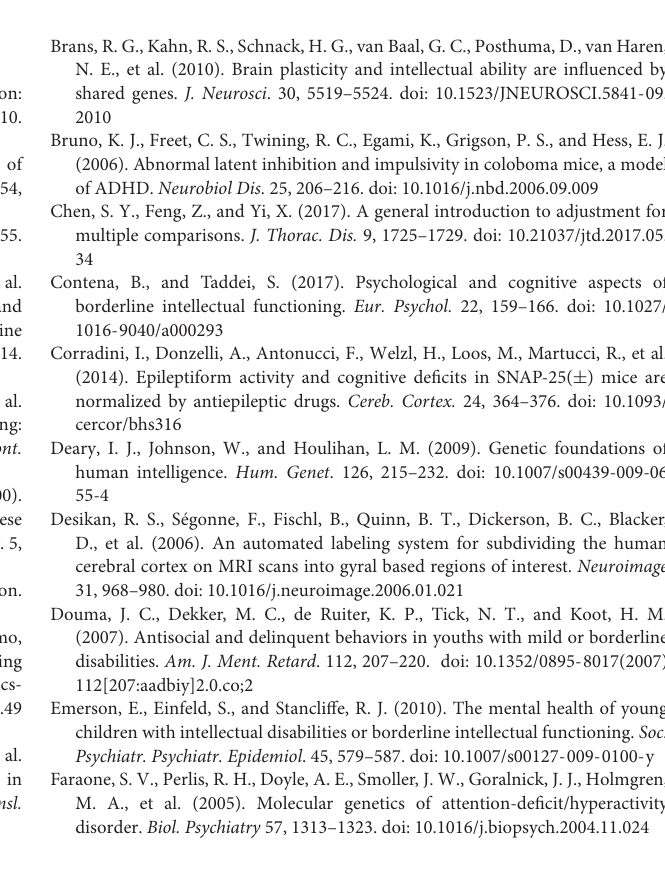
Supplementary Figure 1 | Association Heatmaps between SNAP-25 genotypes and morphological brain features. Dark areas represents significant associations according to the Benjamini–Hochberg procedure. “All statistical significances are in the range between 0.05 and 0.01.” Supplementary Figure 2 | Association Heatmaps between WISC-III scores and morphological brain features. Dark areas represents significant associations according to the Benjamini–Hochberg procedure. “All statistical significances are in the range between 0.05 and